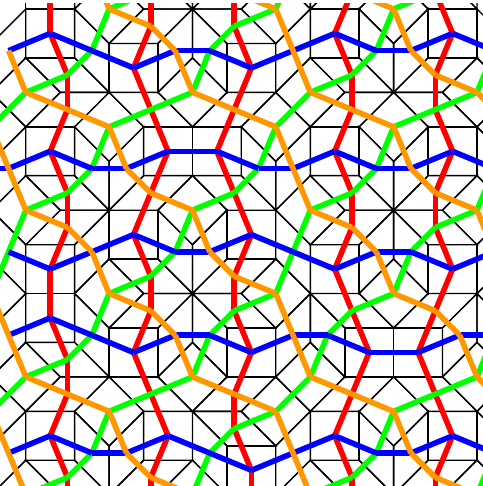
FIG. 2. A construction of the k ¼ 1 quasicrystalline topological phases for a d ¼ 2 , D ¼ 4 quasicrystal. Each color (blue, orange, green, and red) is assigned a 1D SPT invariant that can be chosen independently (if no rotational symmetry is imposed) and represents the 1D SPT phases placed along the corresponding paths. If eightfold rotational symmetry is imposed, there is only one independent SPT invariant.